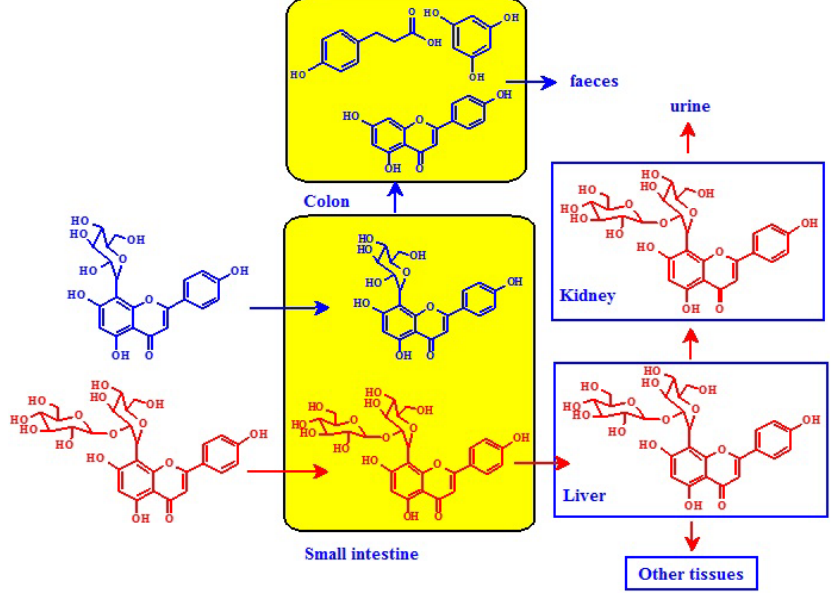
Figure 3. Absorption and metabolism of flavone C -monoglycosides (blue arrow) and C -multiglycosides (red arrow) [63].